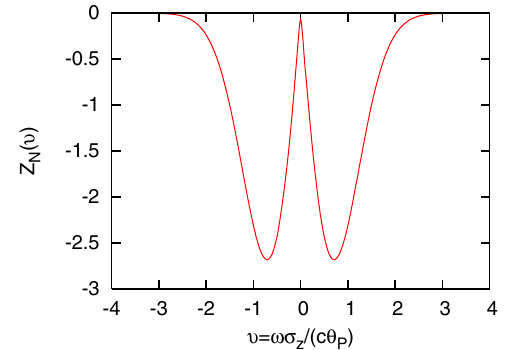
FIG. 3. Imaginary part of normalized cross impedance, where υ ¼ ω ¯ σ Þ = ð c θ z P